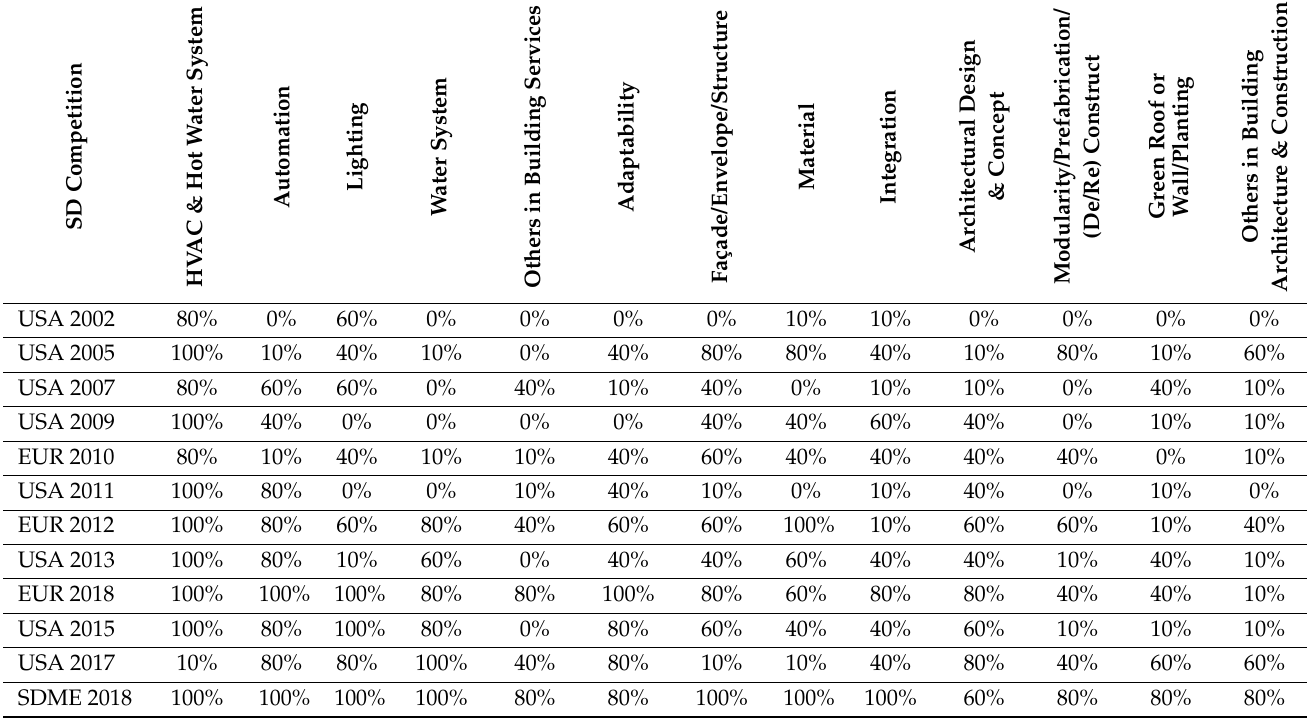
Table 4. Percentage of innovations in SD competitions between 2002 and